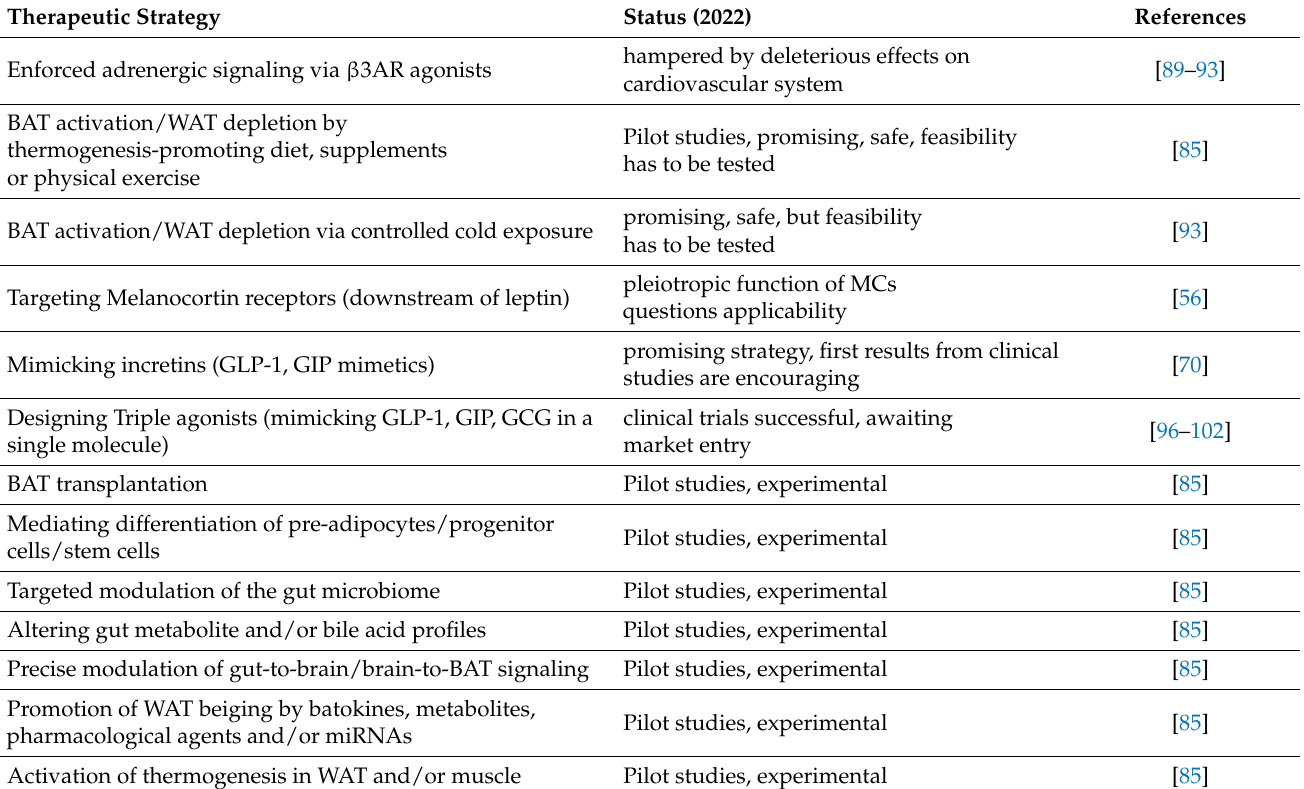
Table 1. BAT-based therapeutic strategies under investigation for treatment of obesity and/or cardiometabolic diseases. See main text for